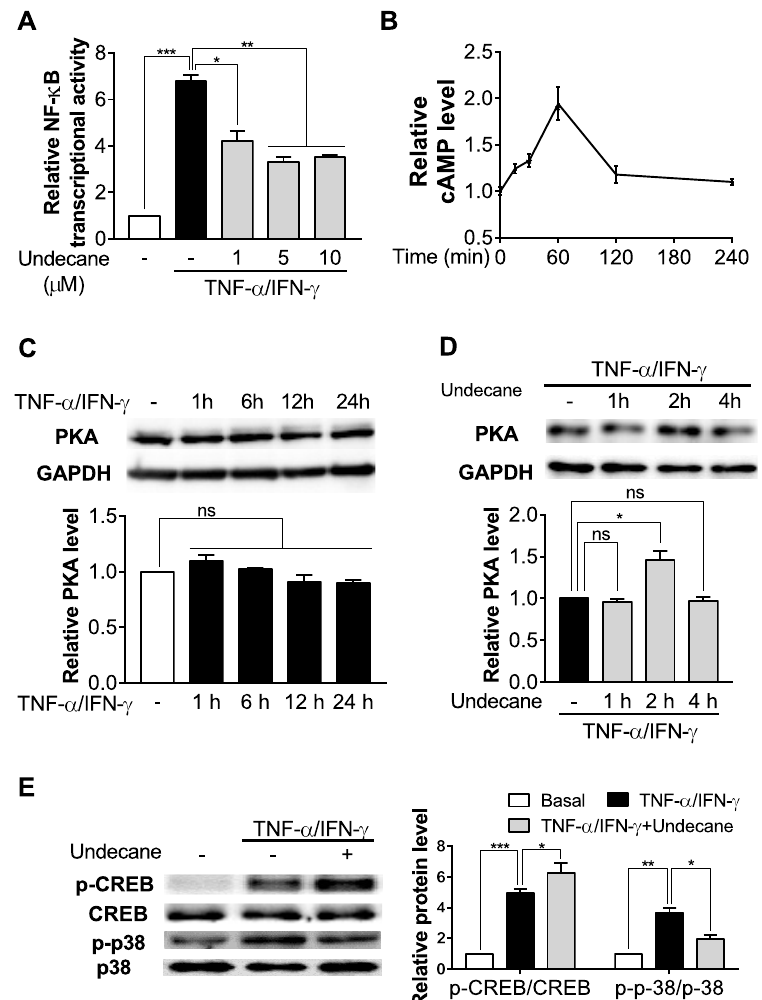
Figure 3. E ff ect of undecane on cyclic adenosine monophosphate (cAMP)-mediated inflammatory signaling pathway in HaCaT cells. ( A ) After pretreatment (1 h) of vehicle (DMSO) or undecane (1, 5 and 10 µ M), the cells were incubated with TNF- α / IFN- γ (10 ng / mL each) for 1 h and nuclear factor kappaB (NF- κ B) transcriptional activity was measured in nuclear extraction of each group. ( B ) HaCaT cells were incubated with undecane (5 µ M) for various times and the e ff ect of undecane on intracellular cAMP levels was determined. Western blot was performed to assess the protein levels of ( C , D ) protein kinase A (PKA), ( E ) p-CREB, cAMP-response element-binding protein (CREB), p-p38 and p38 in HaCaT cells. ( C ) HaCaT cells were incubated with TNF- α / IFN- γ (10 ng / mL each) for various times and PKA level was measured. ( D ) In a similar manner, TNF- α / IFN- γ -stimulated HaCaT cells were cultured with vehicle or undecane for various times and PKA level was determined. ( E ) After pretreatment (1 h) of vehicle or undecane (5 µ M), the cells were incubated with TNF- α / IFN- γ for 1 h and phosphorylation of CREB and p38 was measured. All the protein expression data were normalized against glyceraldehyde 3-phosphate dehydrogenase (GAPDH) level. The data were expressed as the mean ± SEM ( n = 3). Significant di ff erences between groups are indicated by asterisks; ns, not significant ( p > 0.05); * p < 0.05; ** p < 0.01; *** p <